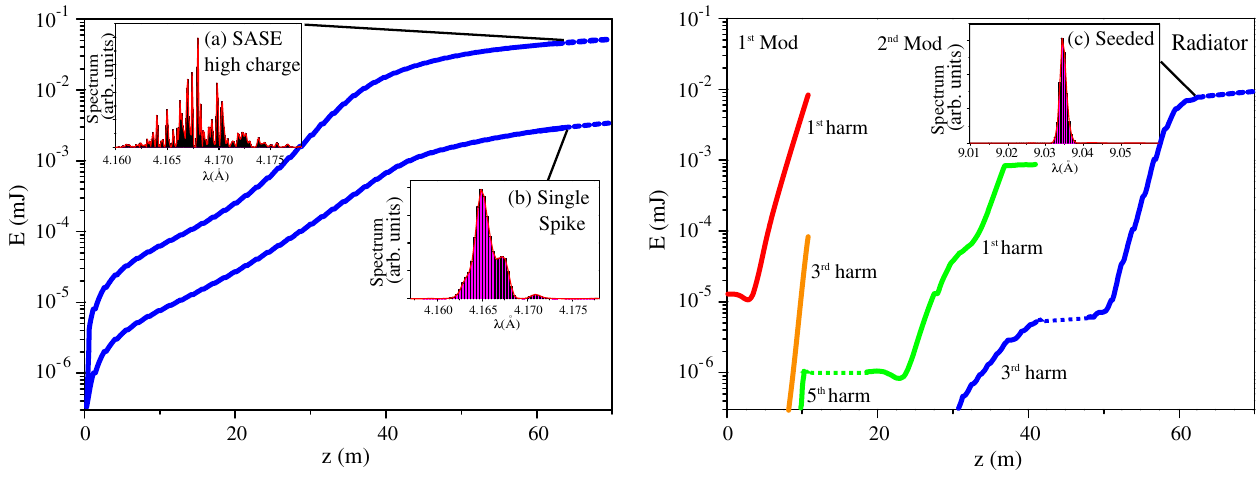
FIG. 14. FEL radiation energy vs undulator position and spectra (in the boxes) extracted at 60 m. Left window: (a) SASE case obtained in UliX2 with Q ¼ 50 pC. (b) SASE single spike, same parameters as (a), but Q ¼ 8 pC. Right window: (c) Seeded cascaded fresh- bunch case. First modulator (1st Mod) with 5 cm period. Second modulator (2nd Mod) with 2.8 cm period. Radiator with 1.2 cm period. The FEL simulations have been performed with GENESIS